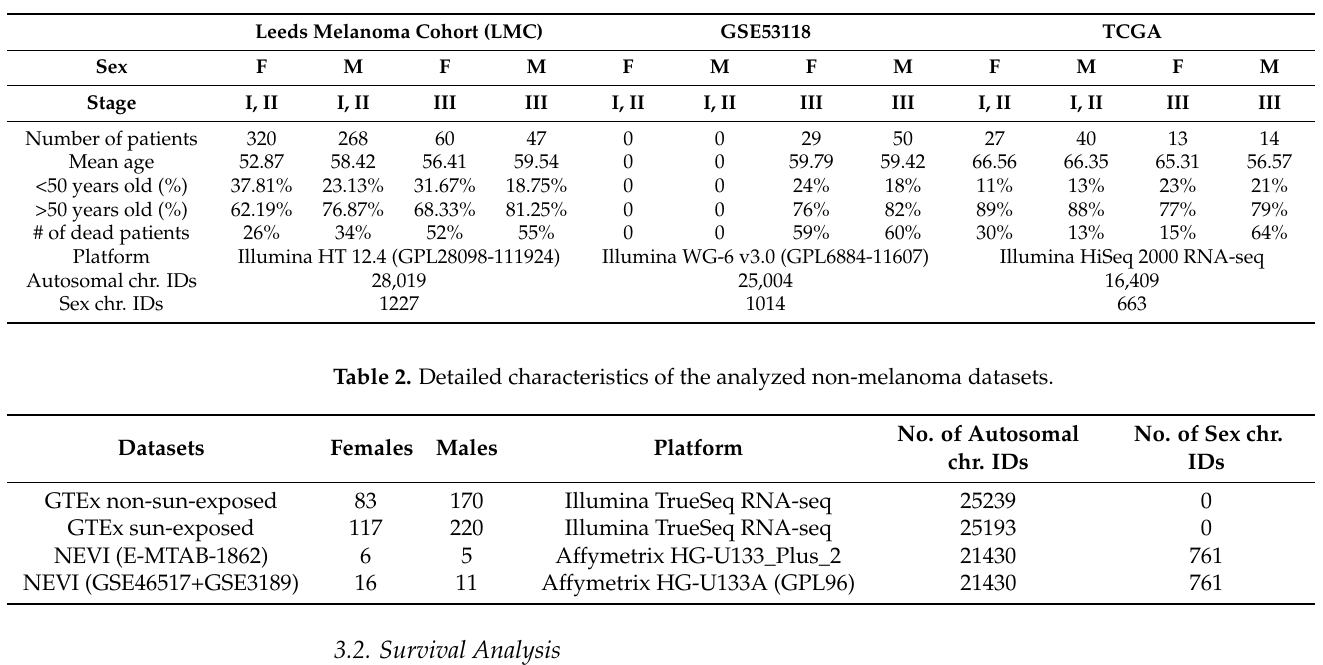
Table 1. Detailed characteristics of the analyzed melanoma datasets (st = stage).